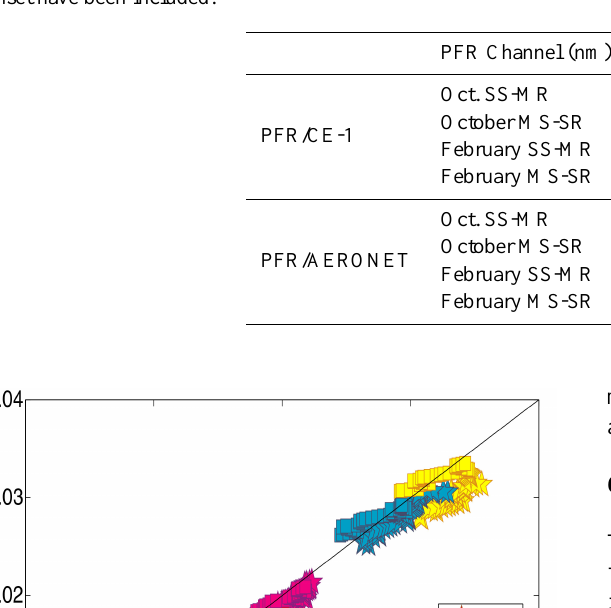
Table 5. τ a averaged differences on 11 to 12 October 2011, and 8 to 9 February 2012, between daytime PFR and nocturnal CE-1 data during sunset-moonrise (SS-MR, the last 1-h of daytime PFR data versus the first 1-h of nocturnal CE-1 data) and moonset-sunrise (MS-SR, as the first 1-h of daytime PFR data versus the last 1-h of nocturnal CE-1 data). τ a differences between PFR and AERONET during moonrise and moonset have been included.